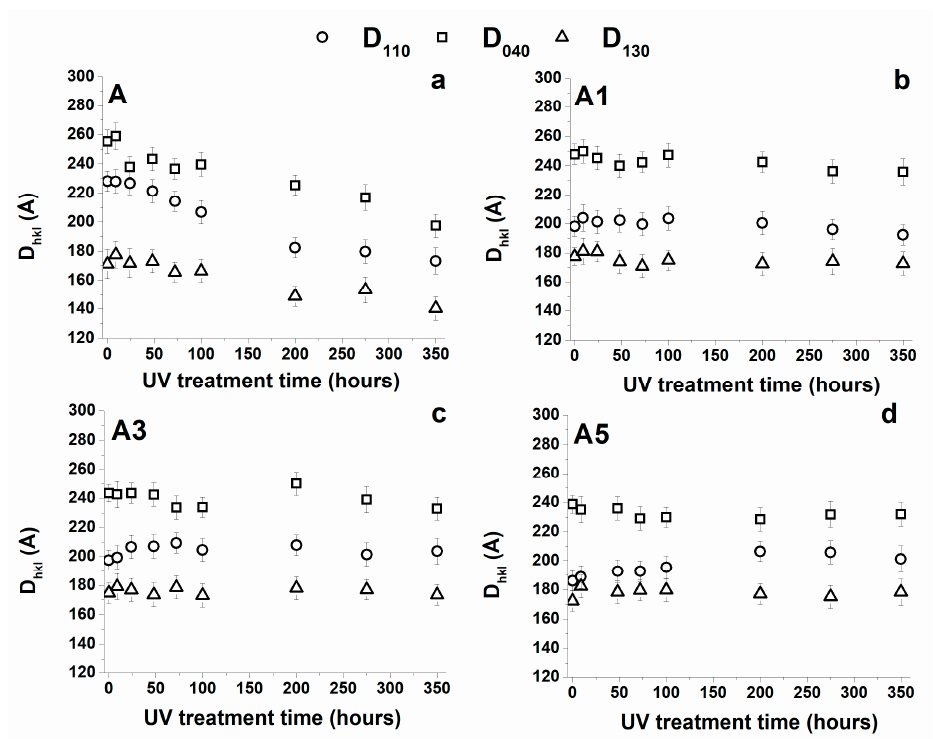
Figure 12. Trend of the Crystallite Coherence Lengths Perpendicular to Reflection Planes 110 (D110), 040 (D040), 130 (D130) for the unfilled and filled samples as a function of UV treatment time.